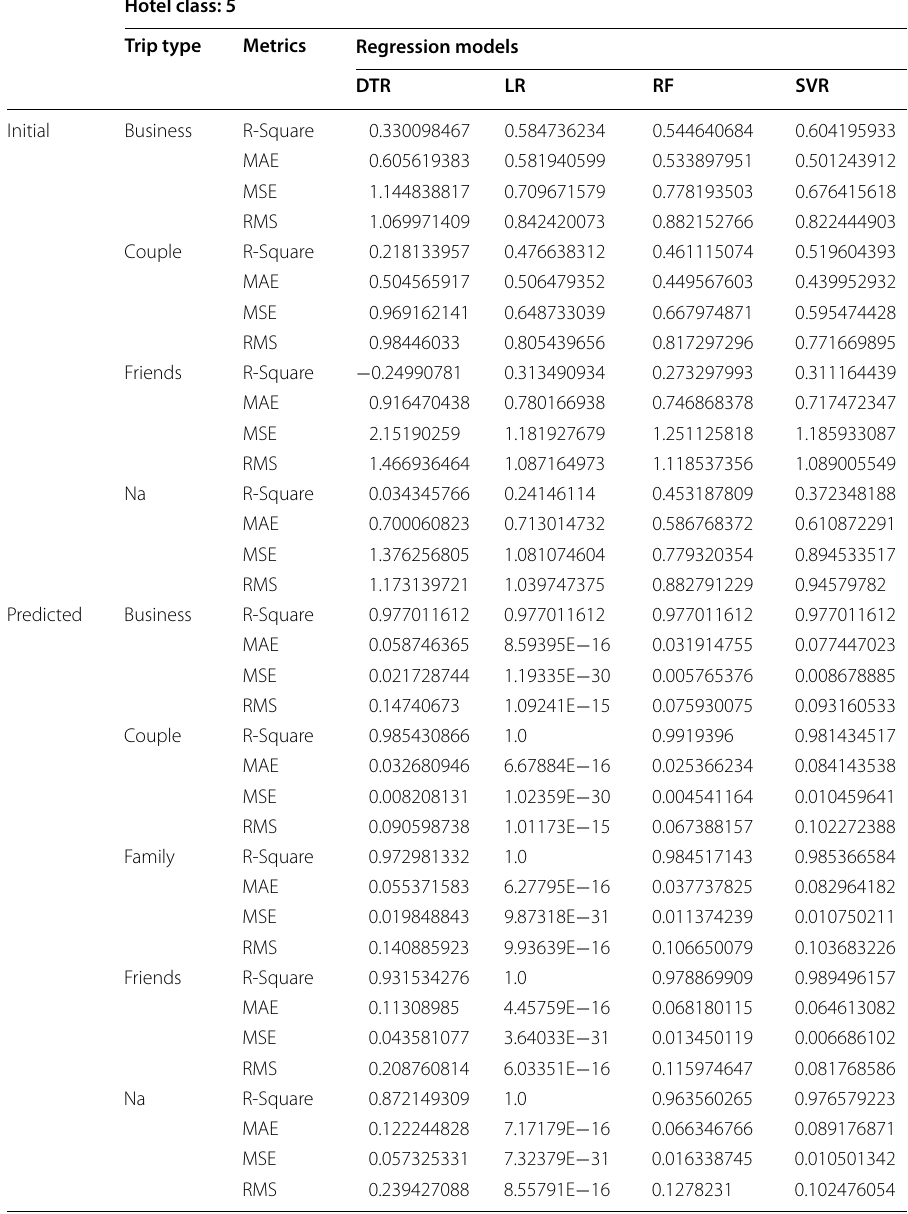
Table 3 Performance analysis on 5 star hotel class based on trip type (Initial and predicted results) Hotel class: